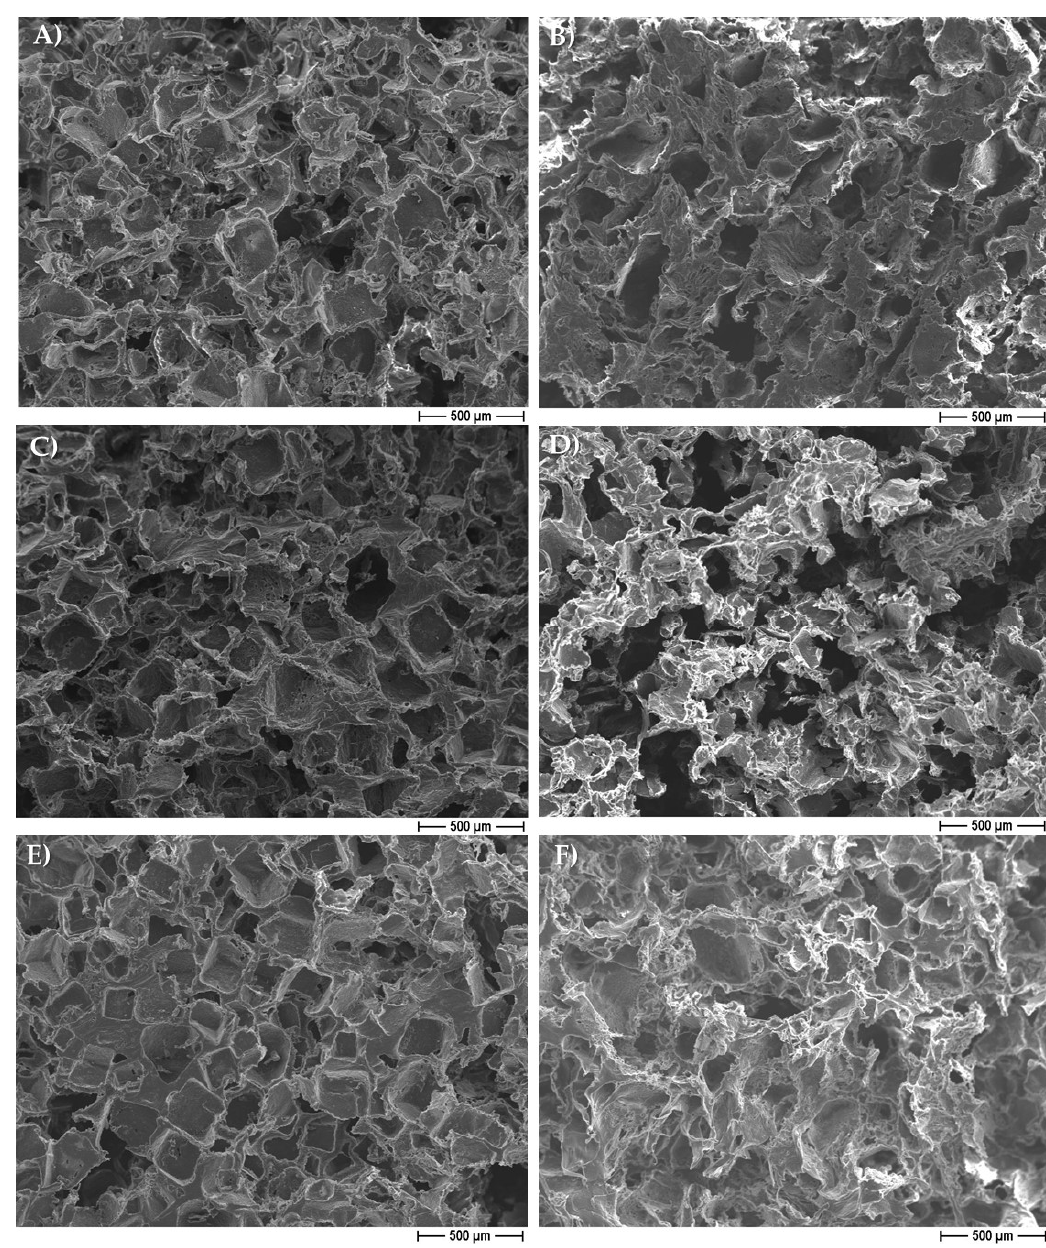
Figure 2. Field emission scanning electron microscopy (FESEM) micrographs of pure poly( ε -caprolactone) (PCL) scaffolds obtained by using sodium chloride, NaCl ( A ), and sodium nitrate, NaNO 3 ( B ) salts as templates; micrographs of 30% eugenol-added ( C , D ) and 30% cinnamon oil-added ( E , F ) PCL constructs, showing the same morphology of the neat polymer scaffold.